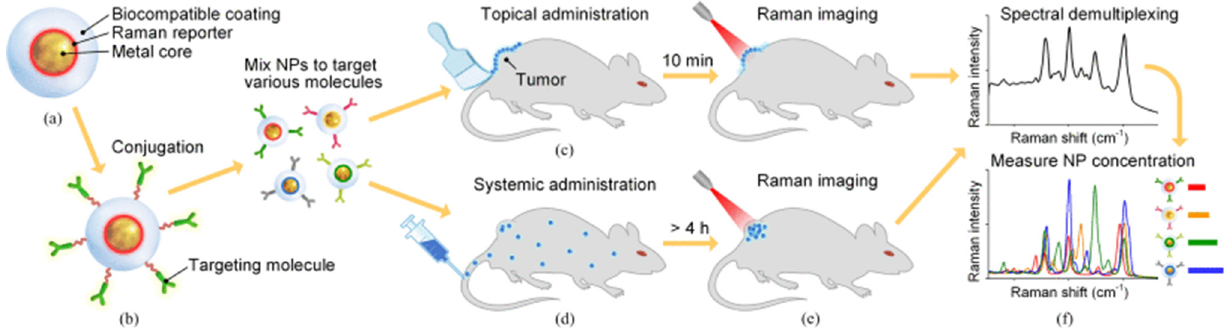
Figure 7. SERS NPs and their application in oncological SERS imaging. ( a ) Typical sandwich structure of SERS NPs. ( b ) SERS NPs functionalization. Operating principle of SERS imaging: ( c ) topical administration of SERS NPs, ( d ) systemic administration of SERS NPs, ( e ) imaging, and ( f ) demultiplexing. Reproduced with permission from [79]. Copyright 2016, IEEE.